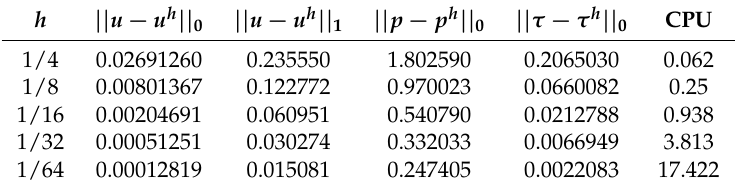
Table 2. The error results before addition of stabilized term with FE P 1- P 1- P 1